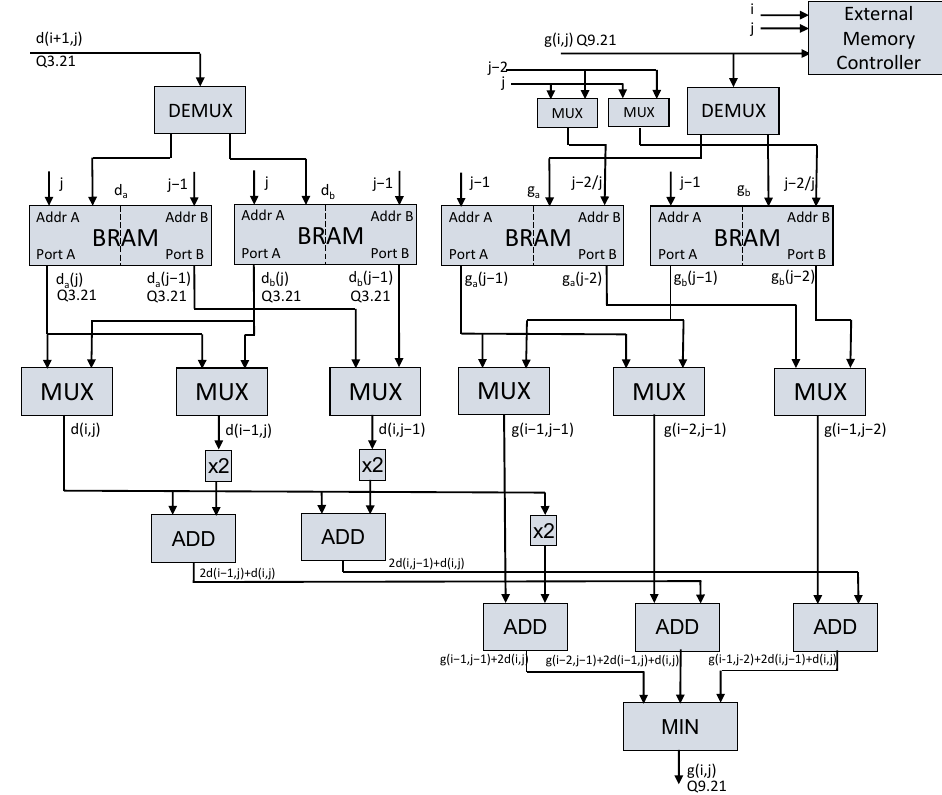
Figure 9. Datapath of the G matrix computing circuit.